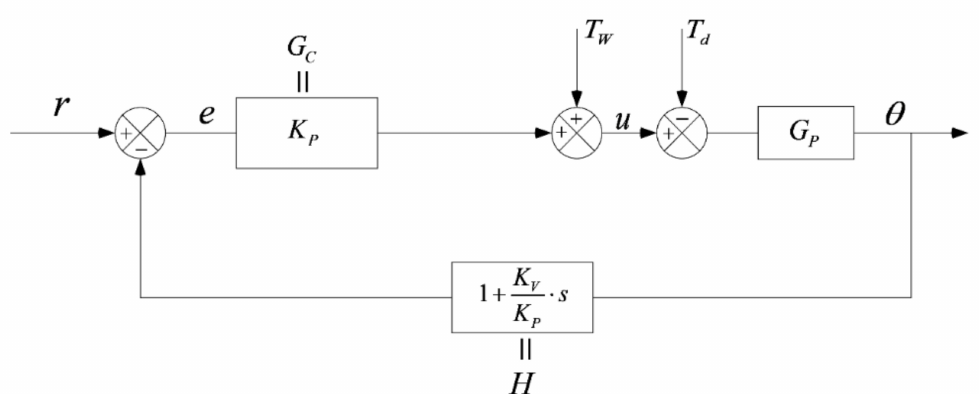
Figure A2. Simplified closed-loop block diagram for a non-linear PV (or PD *) controller with weight compensation T w , where r ( t ) is the reference input signal, G c ( s ), G p ( s ) and H ( s ) are transfer functions of controller, plant and feedback loop, respectively, and T d is a term for the